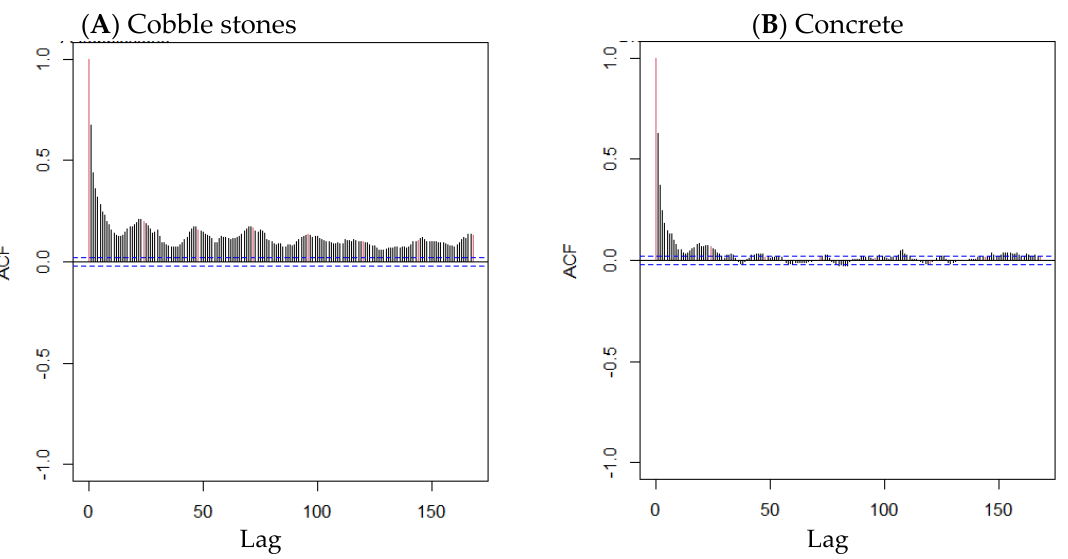
Figure 6. Autocorrelation function (ACF) for time series evaporation. ( A ) ACF for cobble-stones, ( B ) ACF for concrete. The ACF of the original data indicates that the series is not stationary. The dotted line is 2× standard errors.